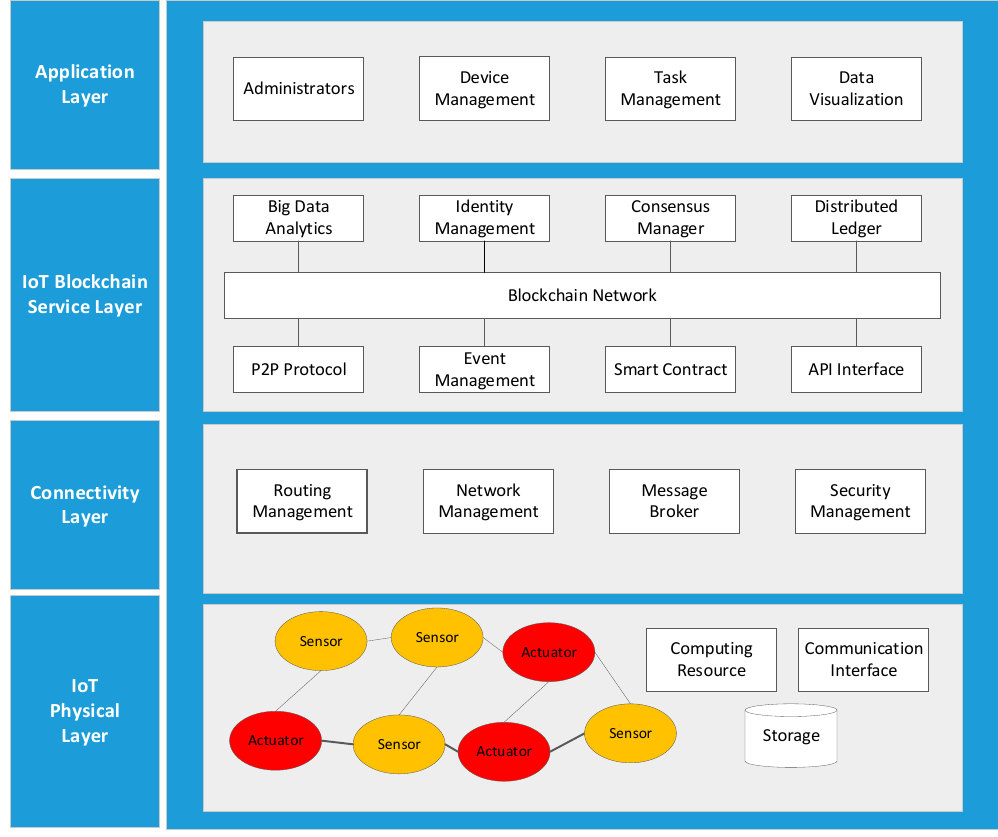
Figure 2. Layer-based IoT blockchain platform architecture.